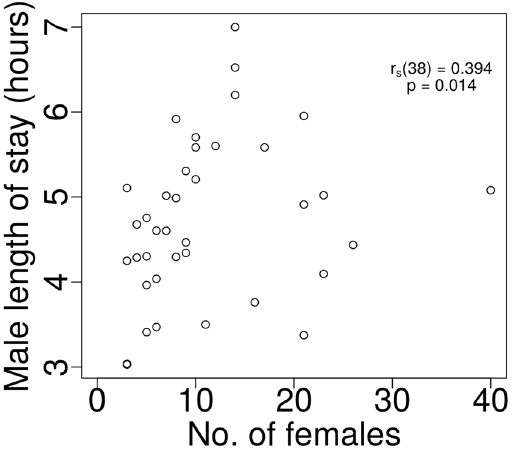
Figure 4. The relationship between male length of stay and the number of females on the spawning ground in the evening spawning